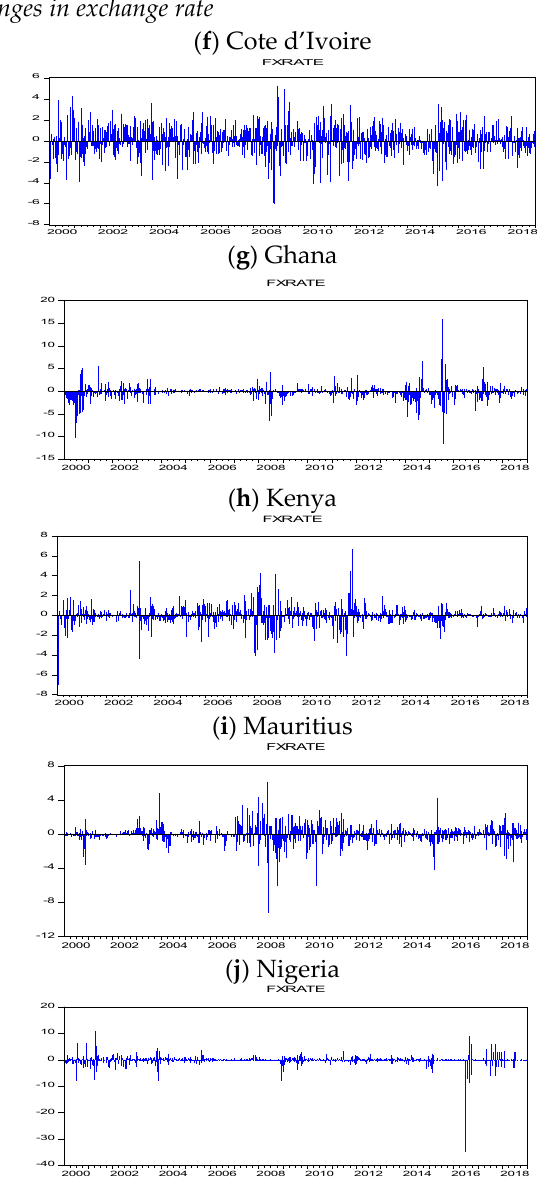
( B ) Plot of stock-market returns and exchange-rate changes in separate graphs Stock-market returns